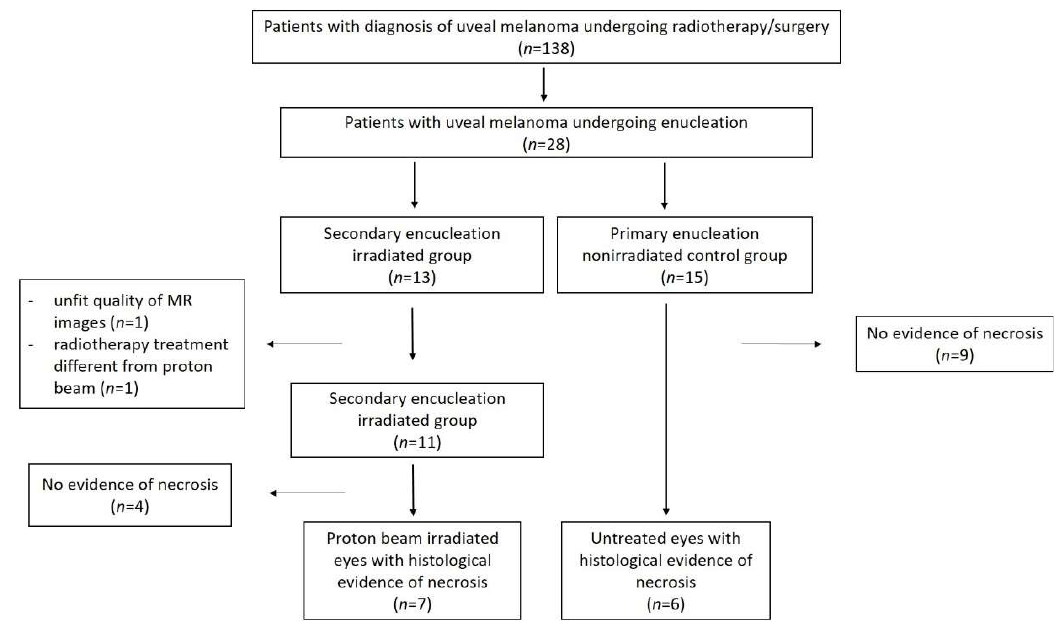
Figure 2. Flow diagram illustrating the patient selection process.